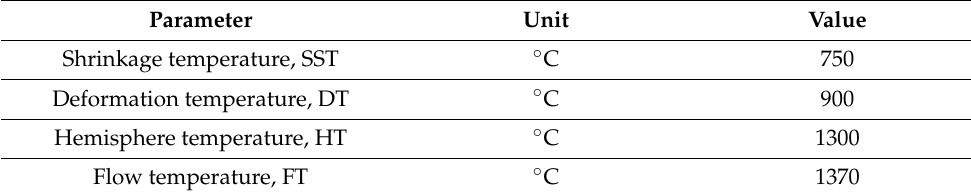
Table 6. Ash melting points (reducing/oxidizing atmosphere). Parameter